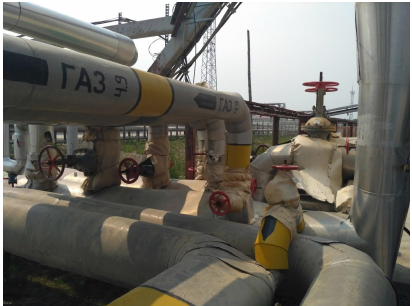
Figure 3 . Digital image of a complicated area with pipelines.